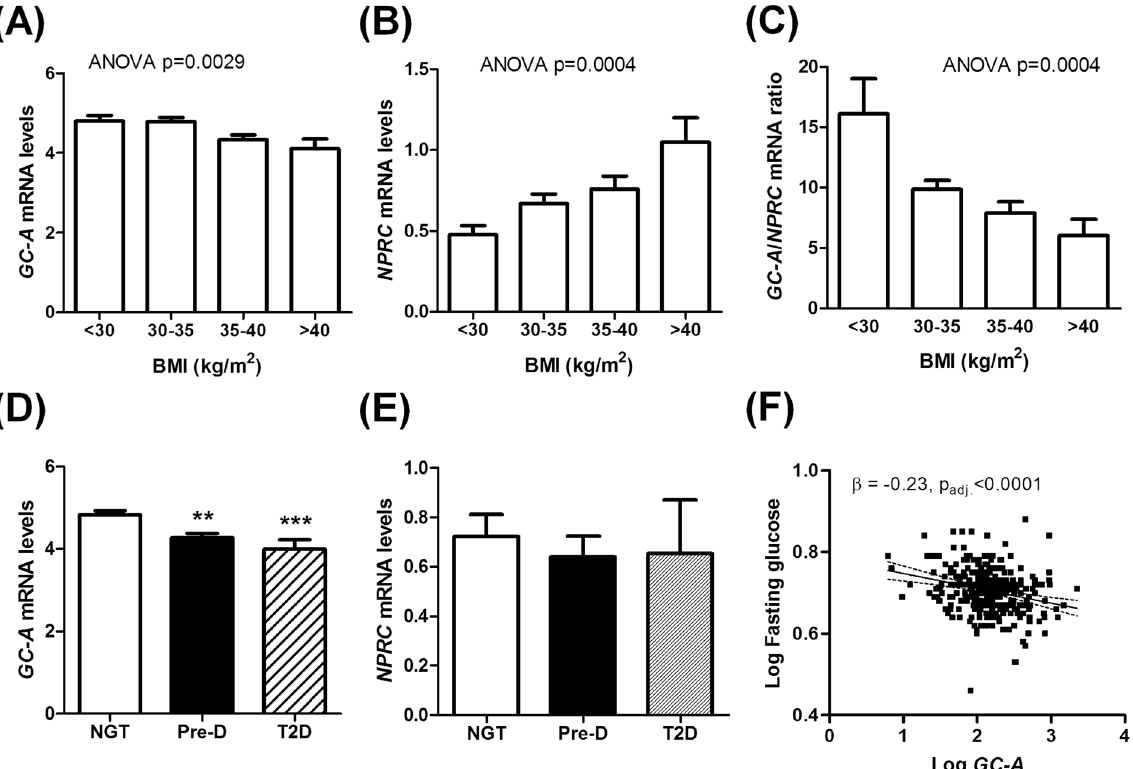
Figure 1. Natriuretic peptide receptor expression in human adipose tissue in obesity and type 2 diabetes. Human adipose tissue gene expression of GC-A ( A ), NPRC ( B ), and the ratio of GC-A -to- NPRC ( C ) as a function of the obesity class. Human adipose GC-A ( D ) and NPRC ( E ) mRNA levels in subjects with normal glucose tolerance (NGT), prediabetes (Pre-D) and type 2 diabetes (T2D). ( F ) Relationship between human adipose GC-A gene expression and fasting blood glucose (n = 311 from cohort 1). ** p < 0.01, *** p < 0.0001 vs. NGT (n = 33–144 per group from cohort